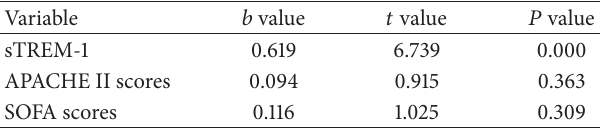
Table 3: Multiple logistic regression